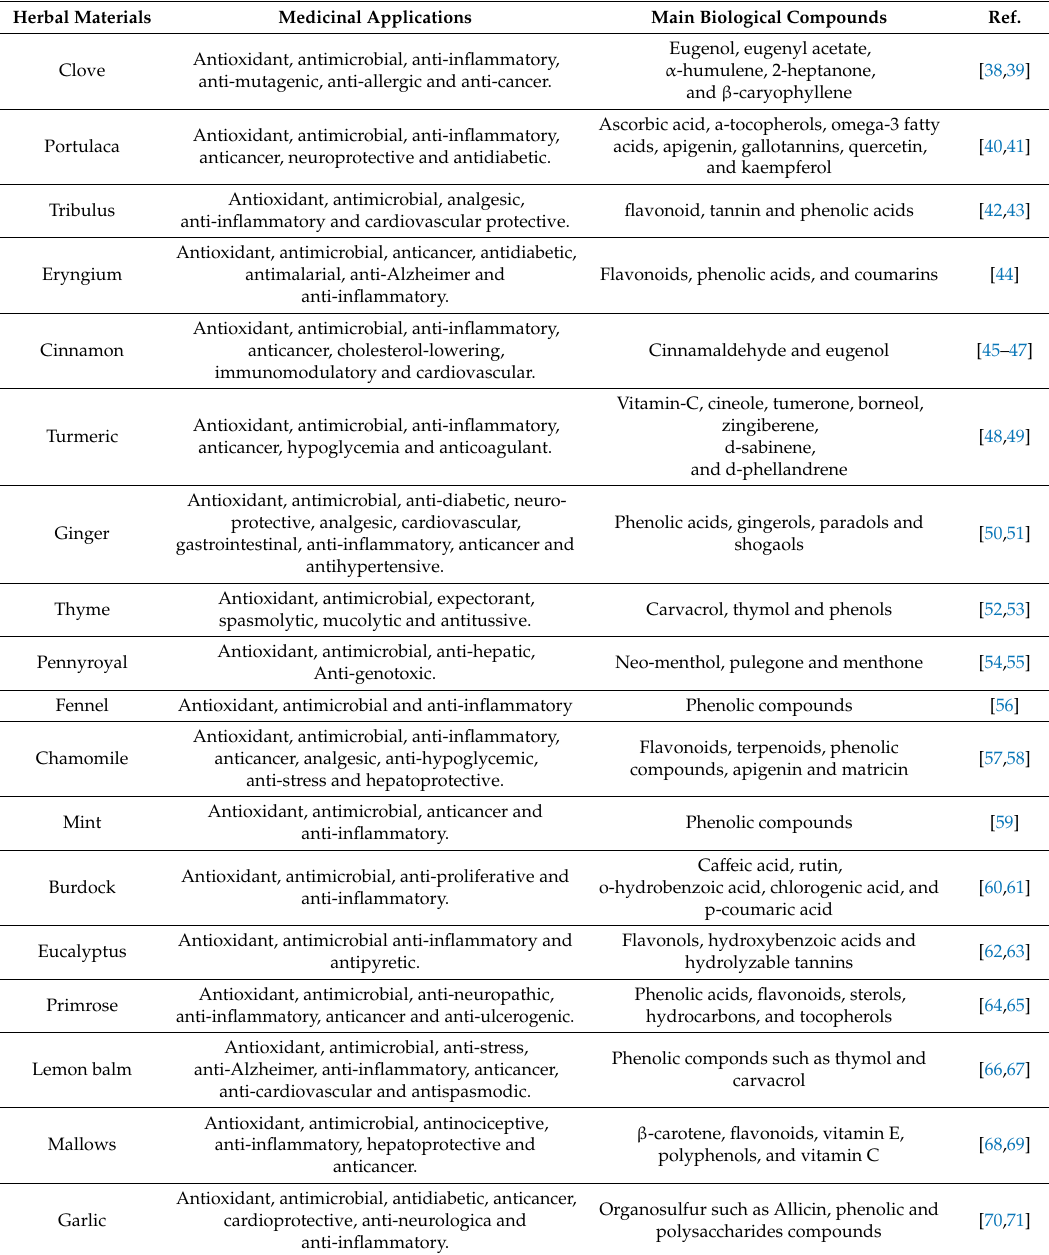
Table 1. A brief list of herbal antimicrobial agents and its medicinal applications and main biological